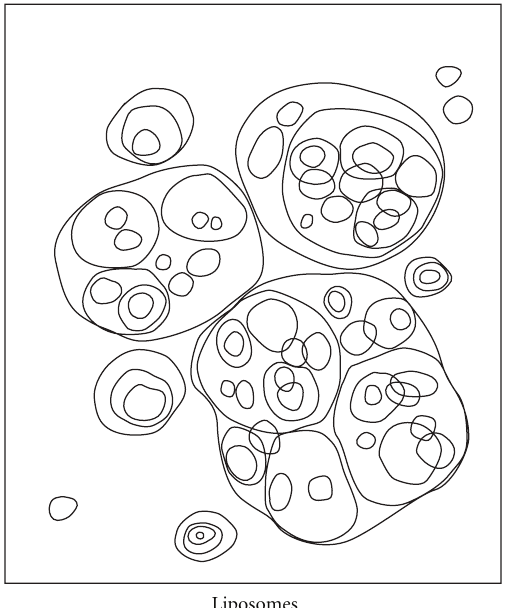
Figure 6: Liposomes.